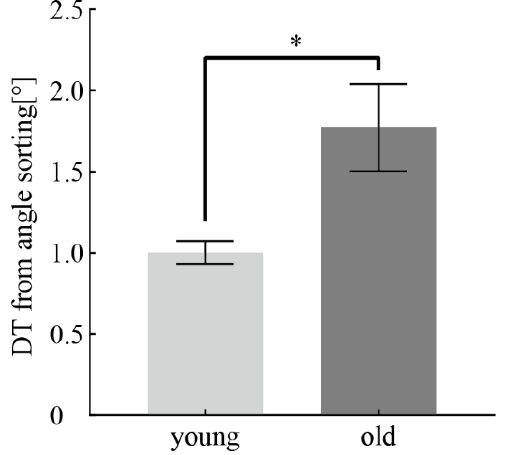
Figure 12. The average of DT from angle sorting in the young and old groups showed that the performance of young participants was significantly better than that of old participants. Values are means ± SEM. (* p < 0.05).